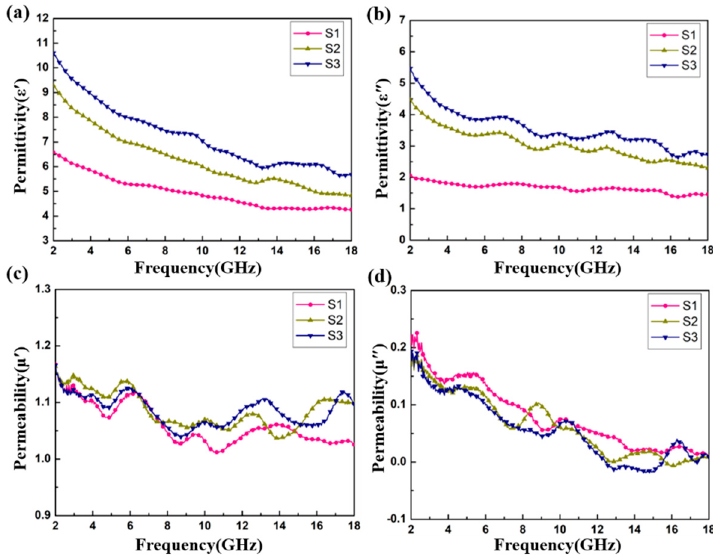
Figure 6. Complex permittivity and permeability of S1, S2, and S3: ( a ) ε′ , ( b ) ε″ , ( c ) μ′ , and ( d ) μ″ .